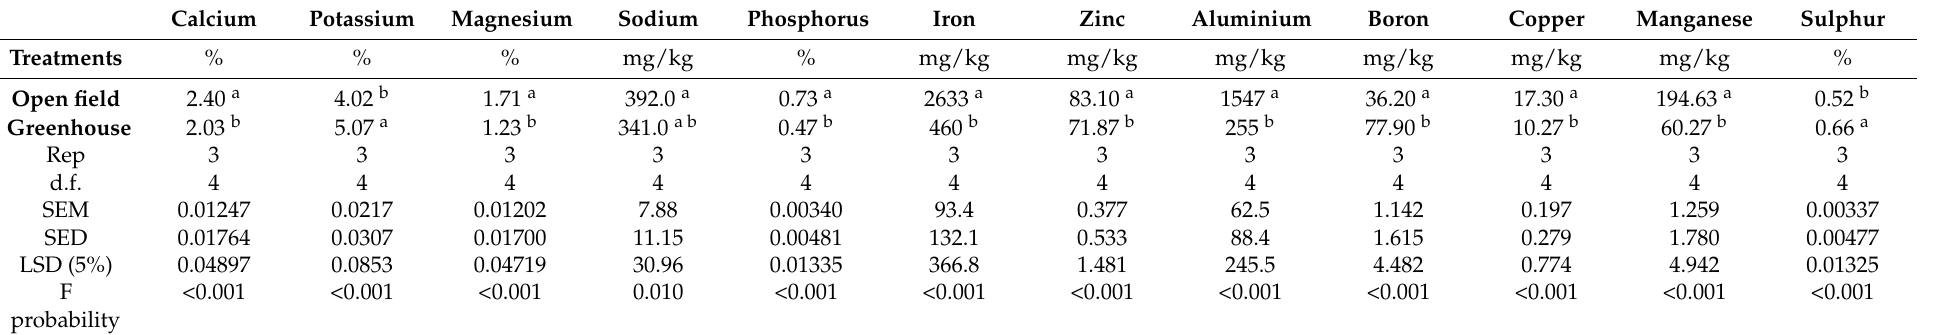
Table 6. Comparison of mineral composition of A. Cruentus L. in open field vs. greenhouse on a dry weight